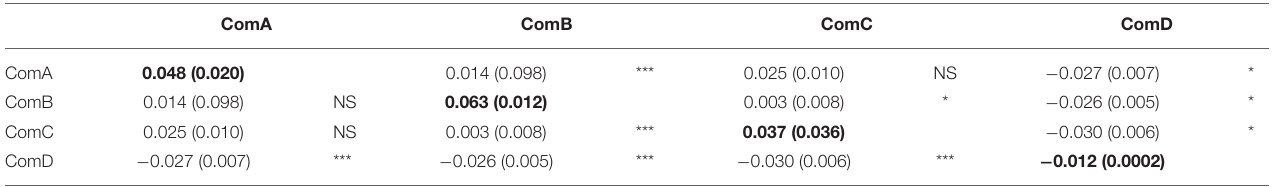
TABLE 6 | Bootstrap mean (and standard error) genetic relatedness (Queller and Goodnight, 1989) for within-community (bold) and with individuals from other communities of bottlenose dolphins (between-community) genotyped with 10 microsatellite loci in Perth metropolitan waters, WA. ComA